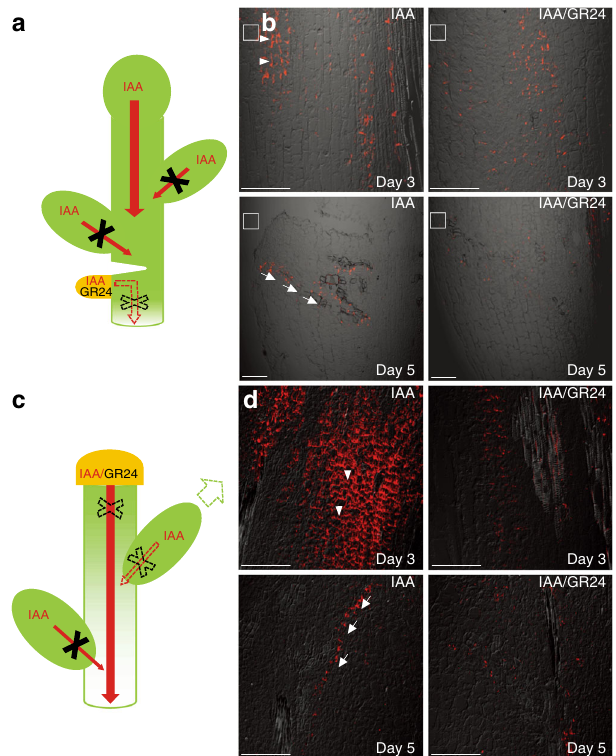
Fig. 1 SL effects on PIN-dependent auxin canalization in pea. a Scheme representing plants wounded below the lower buds. Red arrows represent auxin (IAA) fl ow. Red arrows crossed with black X represent inhibited auxin fl ow. Lanolin pastes containing IAA or IAA/GR24 (marked in yellow) were applied to the side of the pea stem below the wound. Dashed red arrow crossed with dashed black X represents formation of a new auxin fl ow route from the auxin source that can be inhibited by GR24 application. b Immunolocalization of PIN1 in the primary stem. The concentrations of IAA and GR24 applied locally in lanolin pastes were 0.16 and 0.09 µ M, respectively. In total, 10 plants were analyzed for each treatment. White rectangles indicate the places of IAA or IAA/GR24 application. Arrowheads indicate polarity of the PIN localization. Arrows indicate newly formed auxin channels. The fl uorescence signals were evaluated on Olympus Fluoview 200 confocal scanning microscope with UPlanFI 20×/0.5 and/or UPlanApo 10×/ 0.40 objectives. PIN1 immunolocalization signals (red) are overlaid with the transmitted light images. Scale bar, 100 μ m. c Scheme of decapitated plants treated with IAA or IAA/GR24 paste on the stump. Red arrows represent auxin (IAA) fl ow. Red arrow crossed with dashed black X represents formation of a new auxin fl ow route from the auxin application to the stump that is inhibited by GR24 application. Dashed red arrow crossed with dashed black X represents intermitted auxin fl ow after temporary bud activation. Dashed green arrow represents temporary bud outgrowth. Red arrows crossed with black X represent inhibited auxin fl ow. d Immunolocalization of PIN1 in the stem of decapitated plants. In total, 10 plants were analyzed for each treatment. Arrowheads indicate polarity of the PIN localization. Arrows indicate newly formed auxin channels. The fl uorescence signals were evaluated on Olympus Fluoview 200 confocal scanning microscope with UPlanFI 20×/0.5 objective. PIN1 immunolocalization signals (red) are overlaid with the transmitted light images. Scale bar, 100 μ m. The above experiments were repeated three times with similar results. Images shown are representative of each